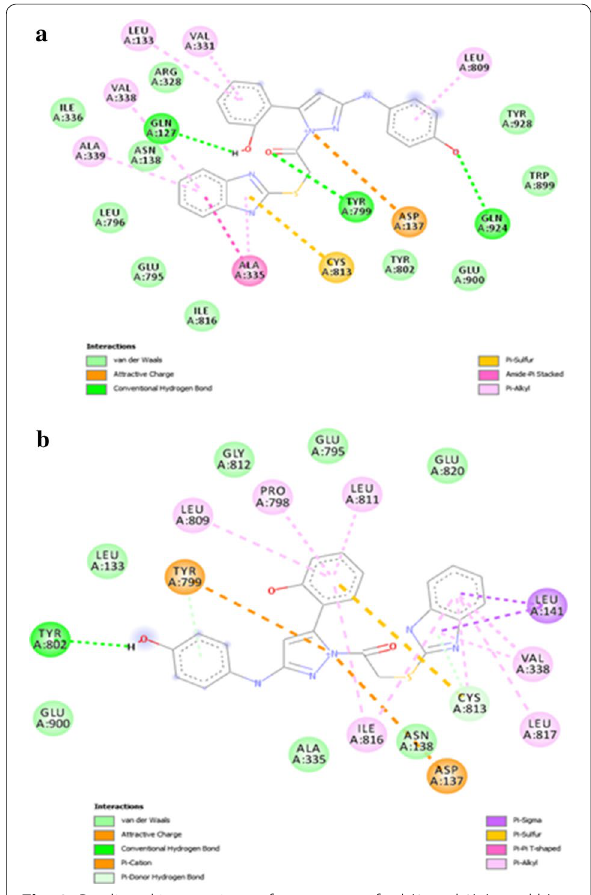
Fig. 8 Predicted interactions of two poses of 5d (0 and 2) (a and b) with active site